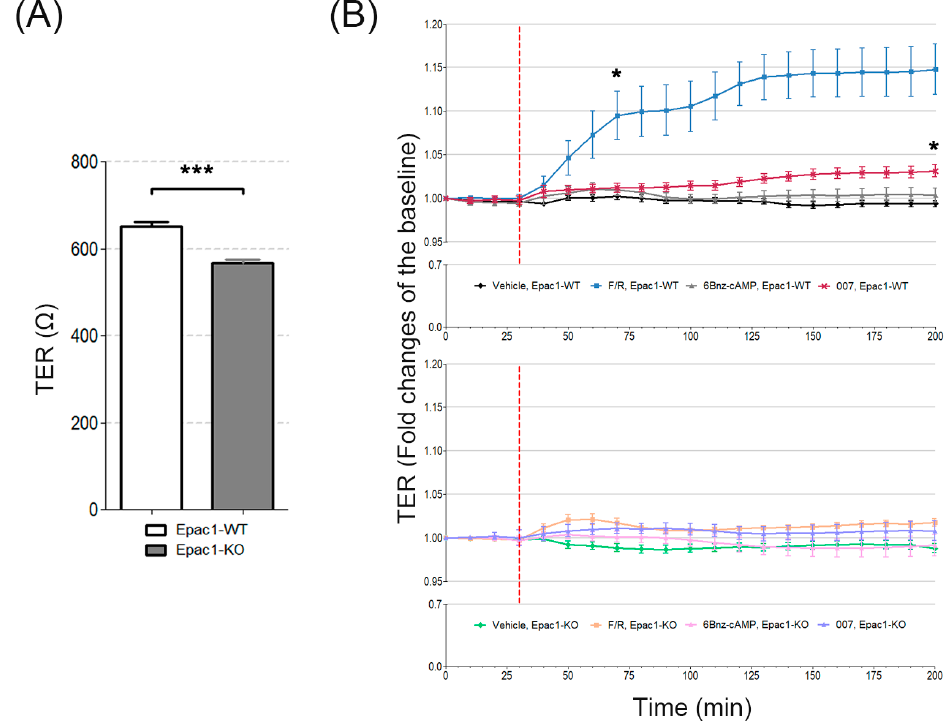
Figure 1. TER from MyEnd monolayers under basal and after the cAMP stimulated conditions. ( A ) Bar diagram representing the average basal transendothelial resistance monitored by ECIS in both WT and Epac1-KO cell lines. Data were collected 200 min after the measurement was initiated. ( B ) Barrier function, over time, from the control and treated (as indicated) WT and Epac1-KO cell monolayers assessed by TER. The segmented red line denotes the time of mediator application. Left asterisk indicates statistically significant difference between F / R stimulated WT cells and the corresponding Vehicle controls. Right asterisk denotes differences between 007 treated WT cells and the respective control monolayers. N = 4–5; n ≥ 8; * p ≤ 0.05, *** p ≤